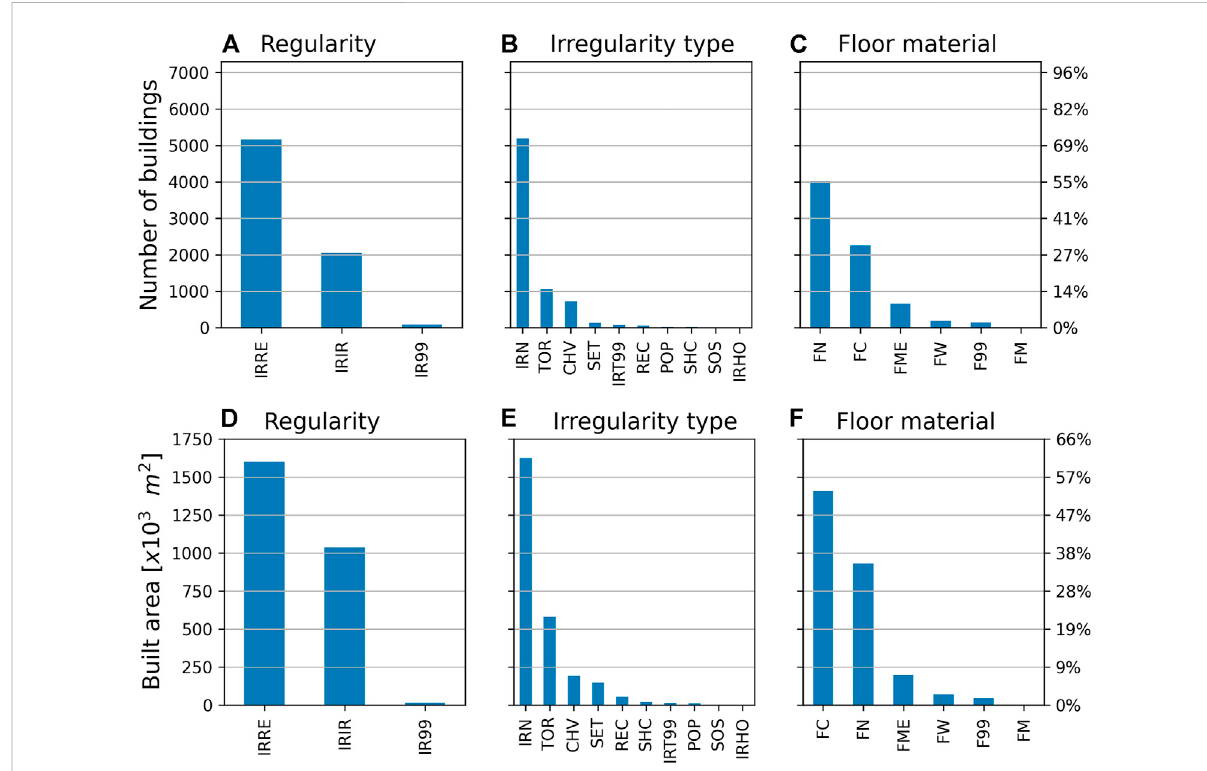
FIGURE 7 Regularity, type of irregularity, and fl oor material distributions. The frequency distribution is shown on the left axis, and the relative frequency is on the rightaxis. F99, fl oor material, unknown; FC, concrete fl oor; FM, masonry fl oor; FME, metal fl oor; FN, no elevated or suspended fl oormaterial; FW, wooden fl oor; IR99, unknown structural irregularity; IRHO, other plan irregularity; IRIR, irregular structure; IRN, no irregularity; IRRE, regular structure;IRT99,structuralirregularitytype,unknown;POP,poundingpotential;REC,re-entrantcorner;SET,setback;SHC,shortcolumn;SOS, soft storey; TOR, torsion